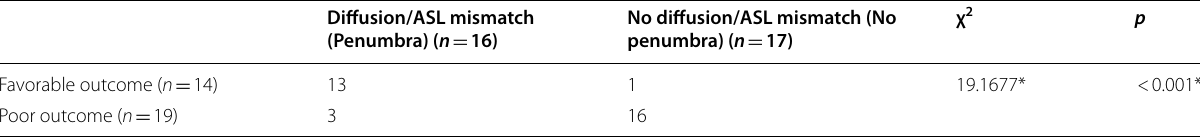
Table 2 Correlation between penumbra status (diffusion/ASL mismatch) and clinical outcome after 3 months (modified Rankin score) in acute stroke patients ( n 33) =